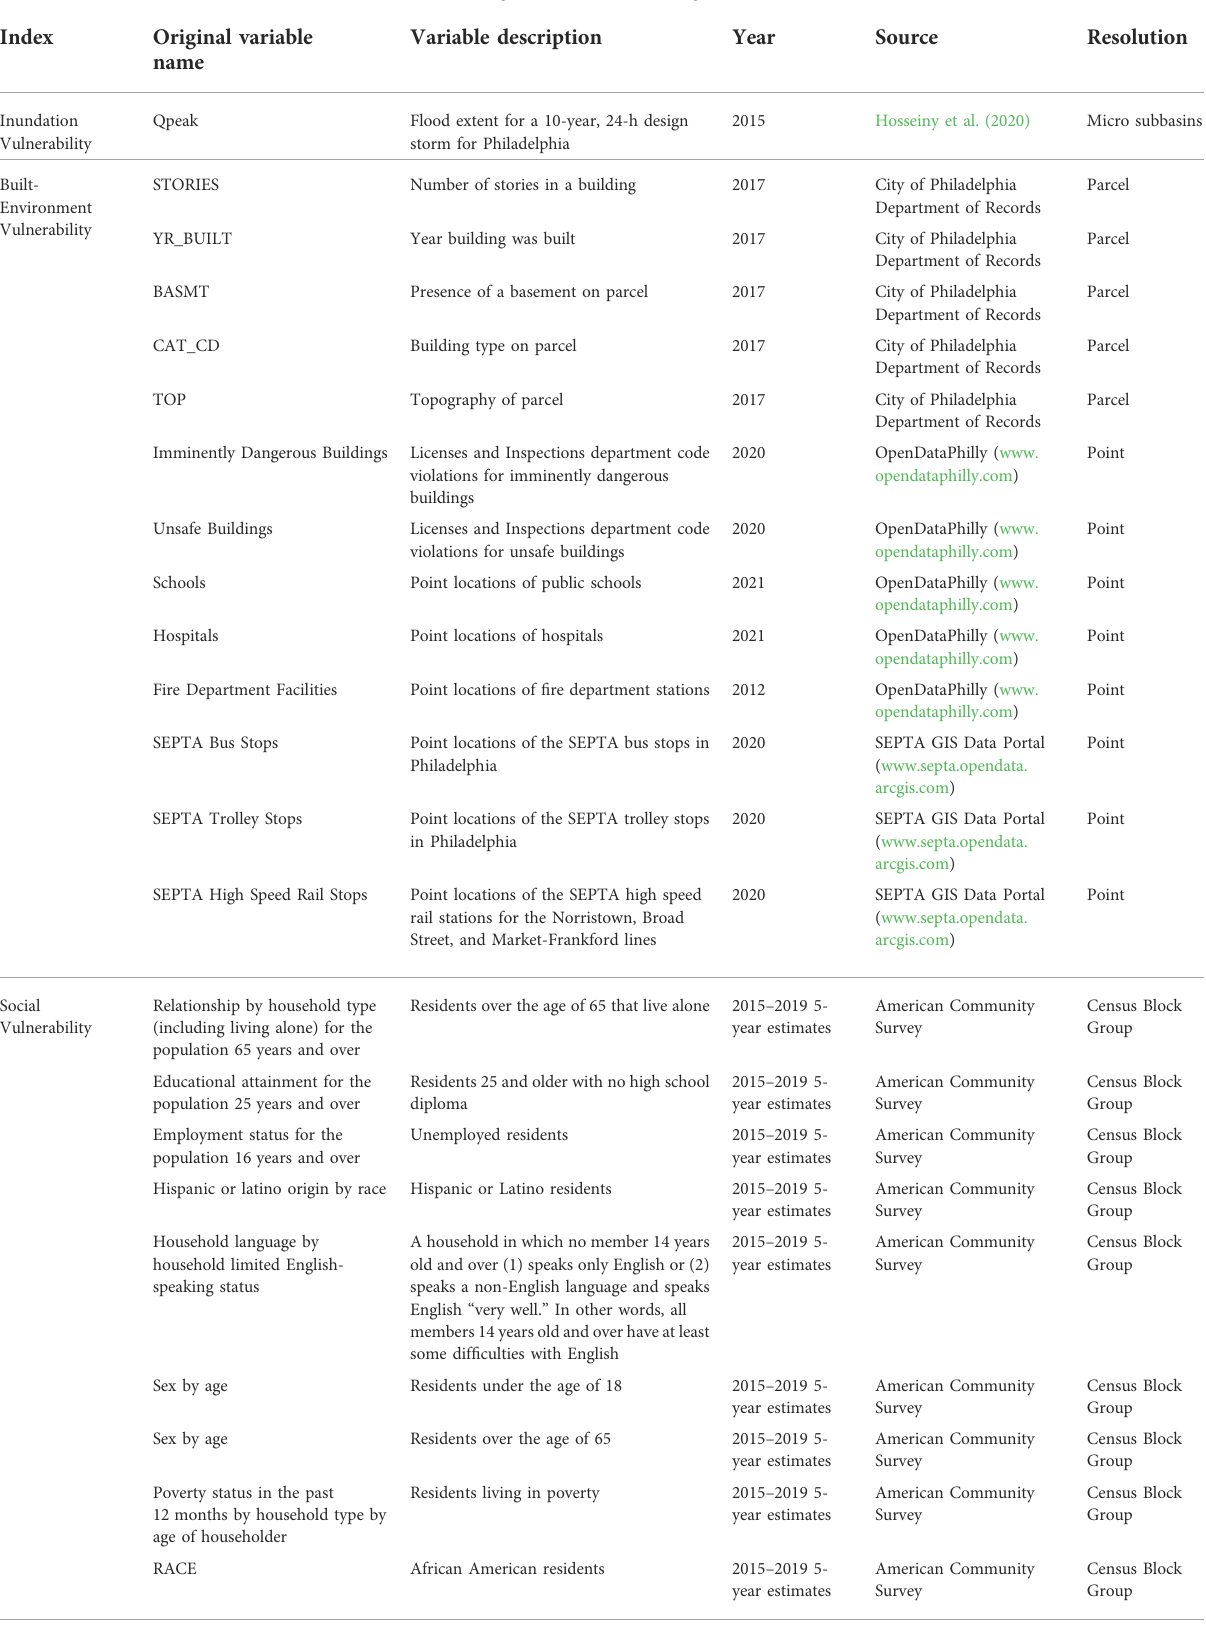
TABLE 1 The variables chosen for each individual vulnerability index within this